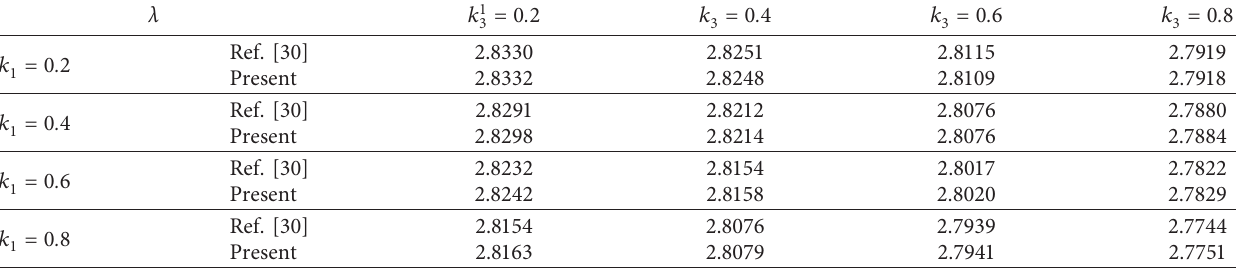
Table 1: Verification of the fundamental frequencies of BDFG beam with L � 20h.